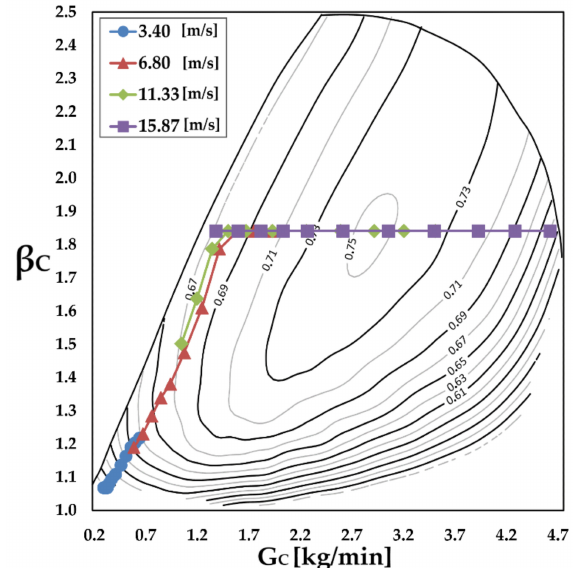
Figure 11. Turbocharger performance map reporting the operating points obtained for every engine load and four mean piston